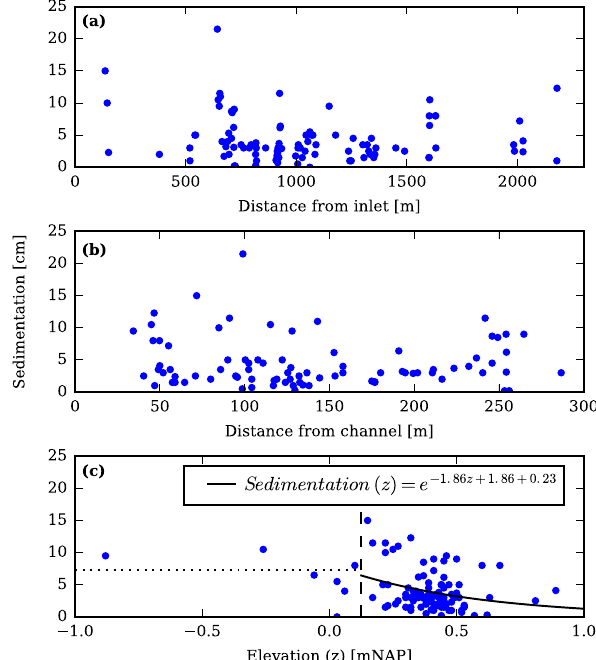
Figure 7. Total sedimentation during the period 2008–2014 in the subtidal and intertidal area, with respect to the distance from the in- let of the system (a) , distance from the channel (b) , and the elevation (c) . The dotted and thick lines show the models for sedimentation in the subtidal and intertidal area. The second intercept represents the bias correction factor of Ferguson